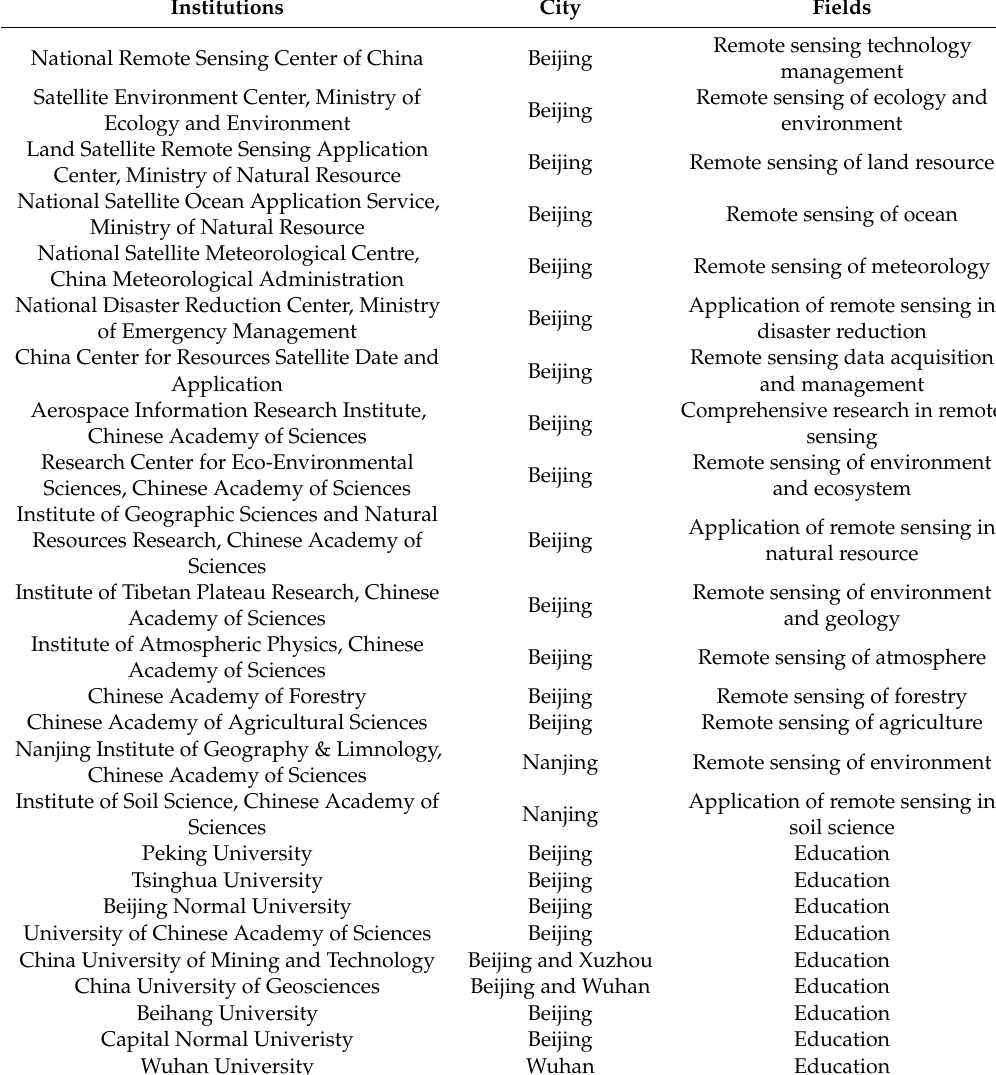
Table 2. Major institutions involved in remote sensing of environment in